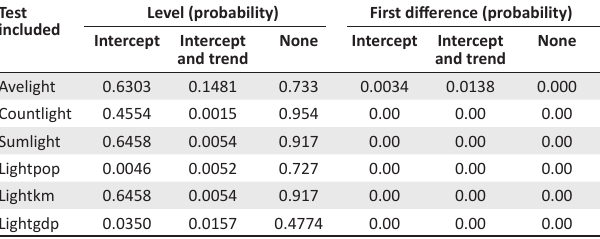
TABLE 2: Summary of the unit root tests results of the various night-time light- related statistics. Test